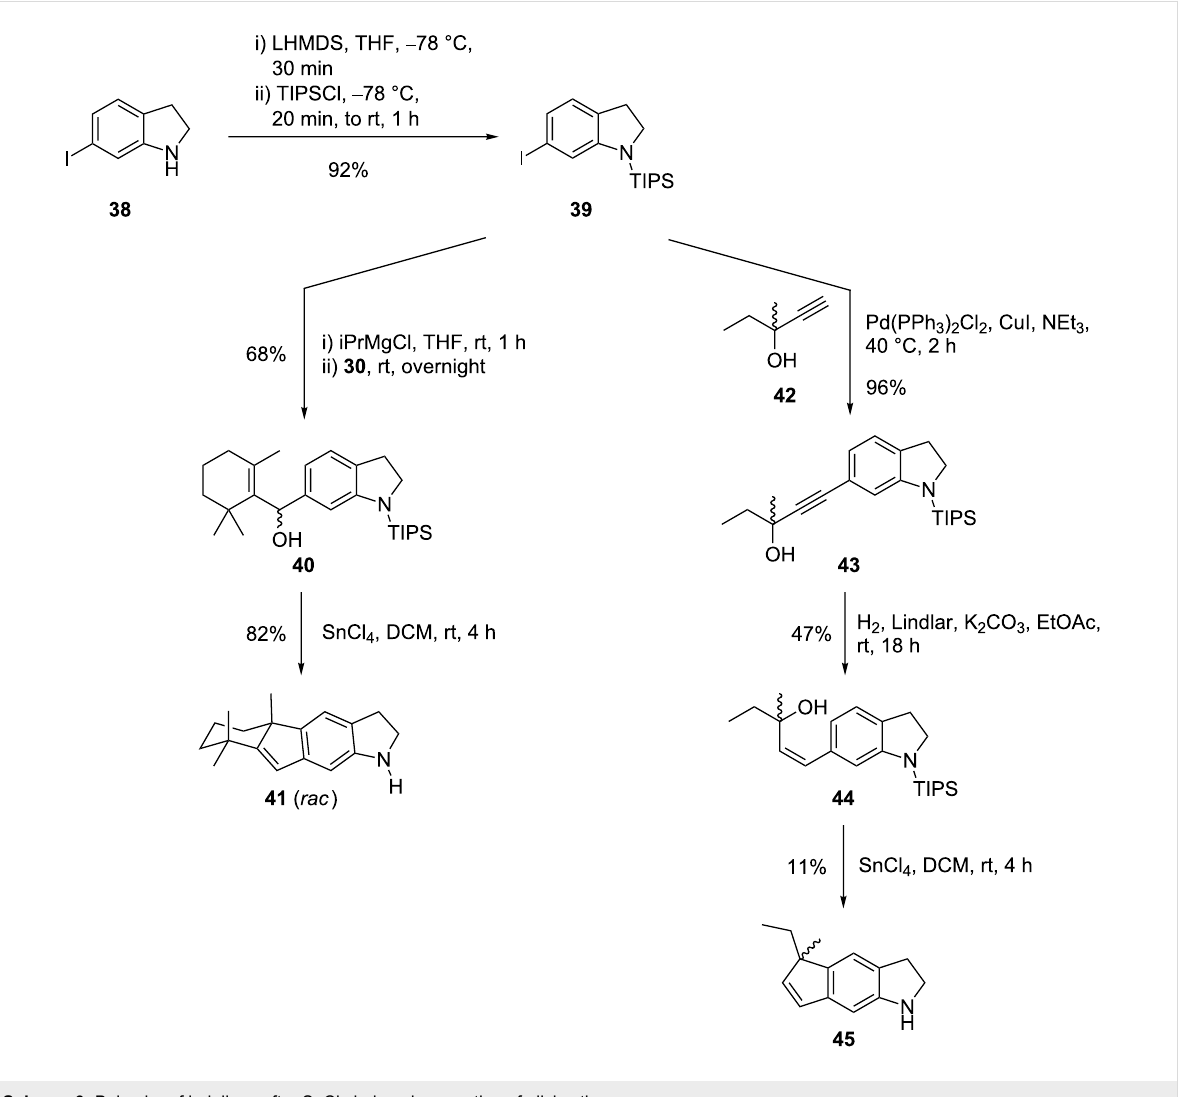
Scheme 6: Behavior of indolines after SnCl 4 -induced generation of allyl